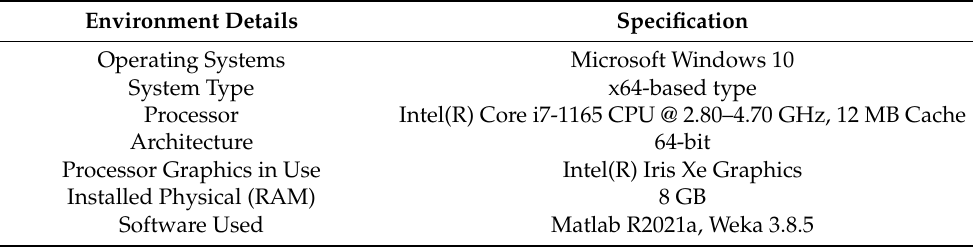
Table 2. Details of the implementation environment used in the current study.